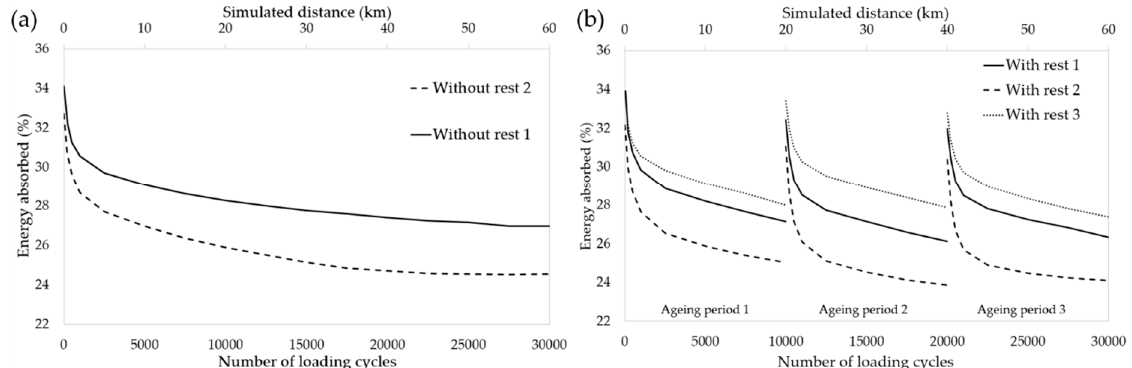
Figure 3. Energy absorbed vs. number of loading cycles, ( a ) without rest periods and ( b ) with rest periods.